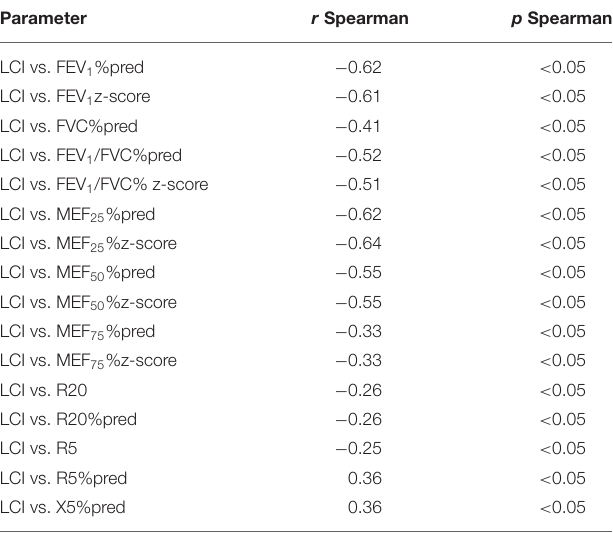
TABLE 3 | Correlation between lung function parameters of CF patient subgroups: subgroup IA without spirometric features of obstruction and IB with obstruction features.